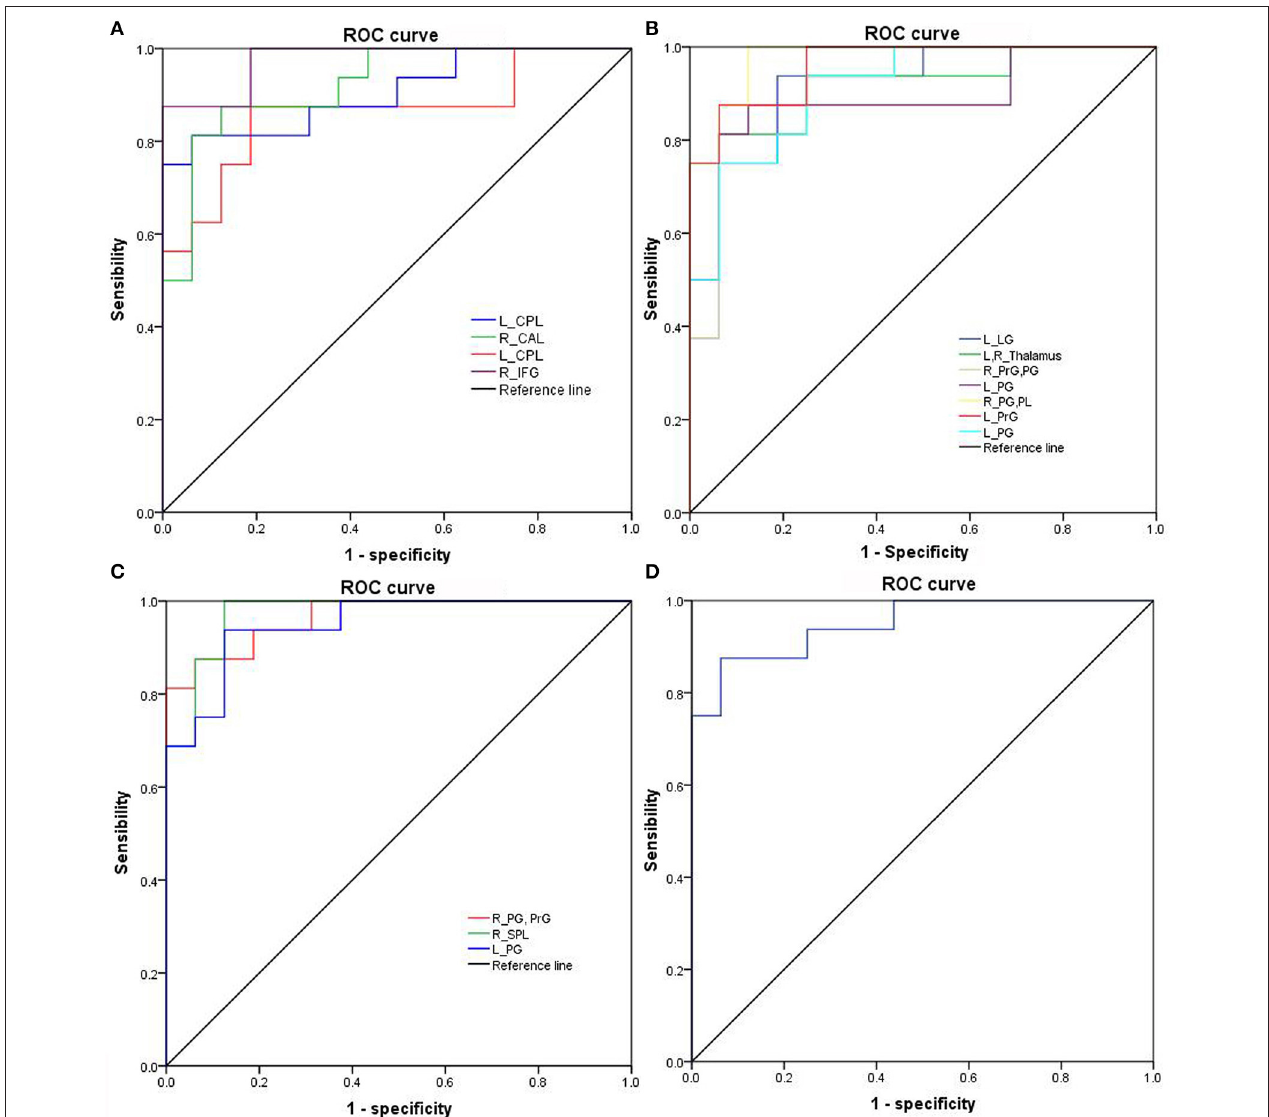
FIGURE 7 | ROC curve of binarized FCD differences in regional brain areas. ROC curve of regional brain areas with decreased binarized shortFCD (A) , increased binarized shortFCD (B) , increased binarized longFCD (C) , and decreased binarized longFCD (D) . ROC, Receiver operating characteristic; R, right; L, left; CPL, Cerebellum posterior lobe; CAL, Cerebellum anterior lobe; IFG, Inferior frontal gyrus; LG, Lingual gyrus; PrG, precentral gyrus; PG, Postcentral gyrus; PL, Paracentral lobule; SPL, Superior parietal lobule; SG, Supramarginal gyrus; SD, Sleep deprivation; RW, Rested wakefulness; shortFCD, short-range functional connectivity density; longFCD, long-range functional connectivity